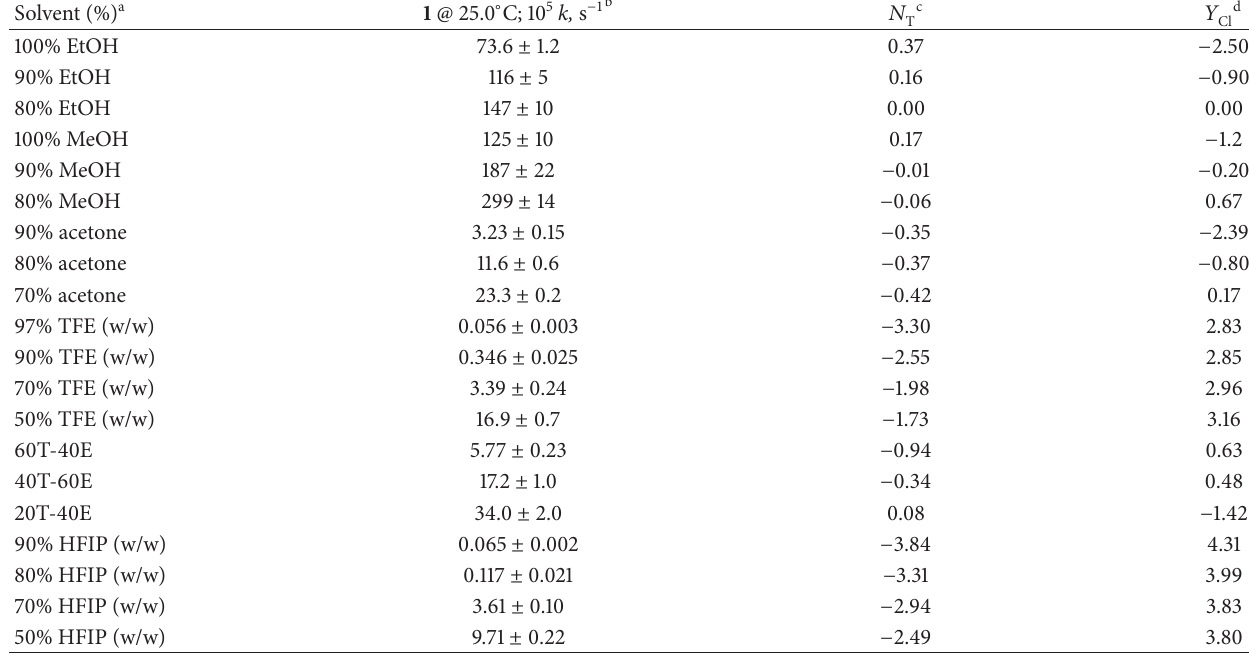
Table 1: Specific rates of solvolysis ( k ) of 1 in several binary solvents at 25.0 ∘ C and literature values for 𝑁 Solvent (%)